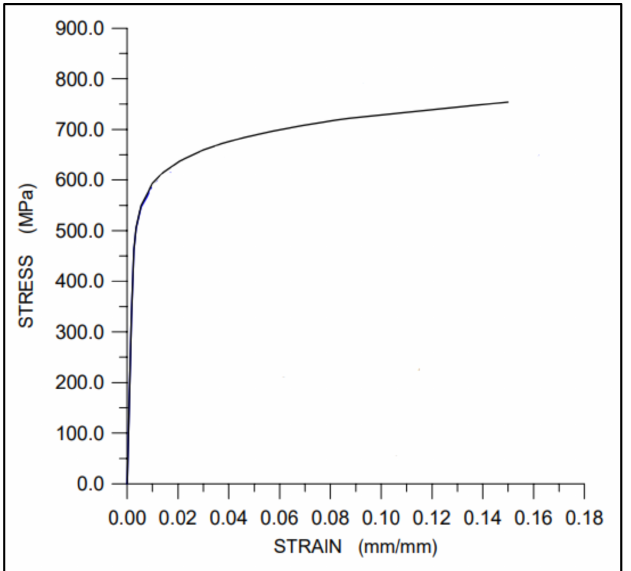
Figure 10. True stress-strain curve for API 5L X80 steel